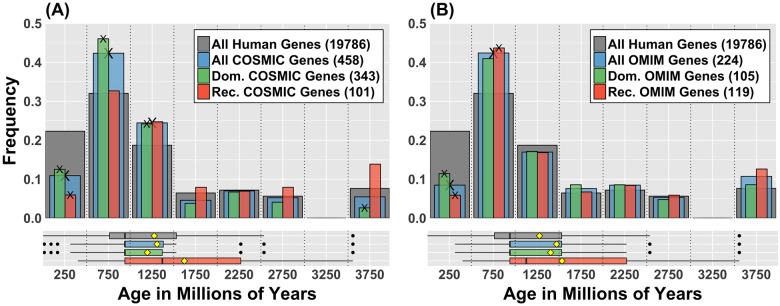
Genes causally implicated in cancer are under-represented among young (<500 MY) genes.(A) Age distribution of dominant (green) and recessive (orange) genes from COSMIC Cancer Gene Census. Grey bars represent the age distribution of all human genes in ENSEMBL, and blue the age distribution of all COSMIC genes. Numbers in legend are the sizes of each gene set. Cross marks (X) on bars tips indicate the enrichment in that category is statistically significant according to Gene Enrichment Score method and a bootstrap test (BSQ < 1%, see Table 1). Accordingly, the second hypothesis predicts that the blue bars should skew to the left with enrichment in both <500 MY and 500–1000 MY. This is not observed. The under-representation of very young genes (less than 500 MY) and the over representation of dominant genes between 500 and 1500 MY are statistically significant. The distinct right skew of the recessive set is also statistically significant (t-test for the difference of the mean with all other sets has p<0.01). This implies that recessive genes are older than expected from random sampling. (B) Similar age distributions for single-gene Mendelian disorders, from the Online Mendelian Inheritance in Man database (OMIM). The general pattern in gene age distributions between dominant and recessive phenotypes observed in cancer, particularly the recessive gene skewness towards old ages and the under-representation of very young genes, is replicated in these gene sets. No notable overrepresentation of dominant genes at moderate ages is detected in this case. The enrichment of cancer genes in such age range is likely associated to breakdown of regulation functions that evolved during the emergence of multicellularity.